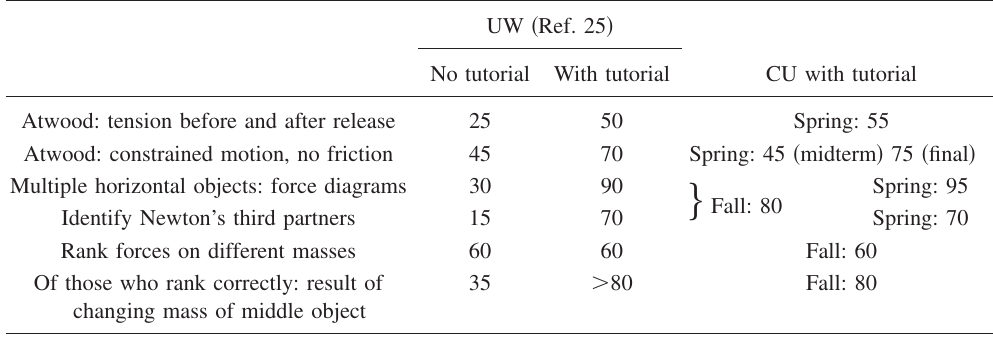
TABLE II. Scores on selected conceptual topics measured on exam questions, rounded to the nearest 5%. (cid:1) See Ref. 43.